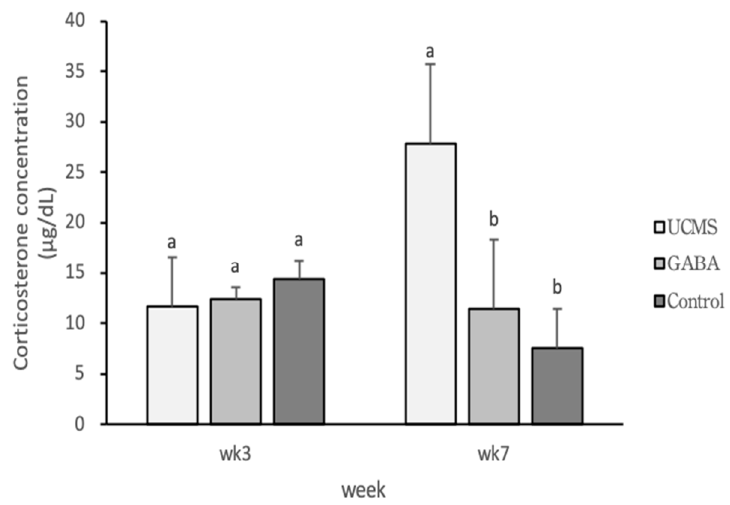
Figure 7. Effect of GABA feed by vegetable soybean on corticosterone content in mice serum. Data are represented as mean ± SD. Group with different letter superscripts are significantly different ( p < 0.05).